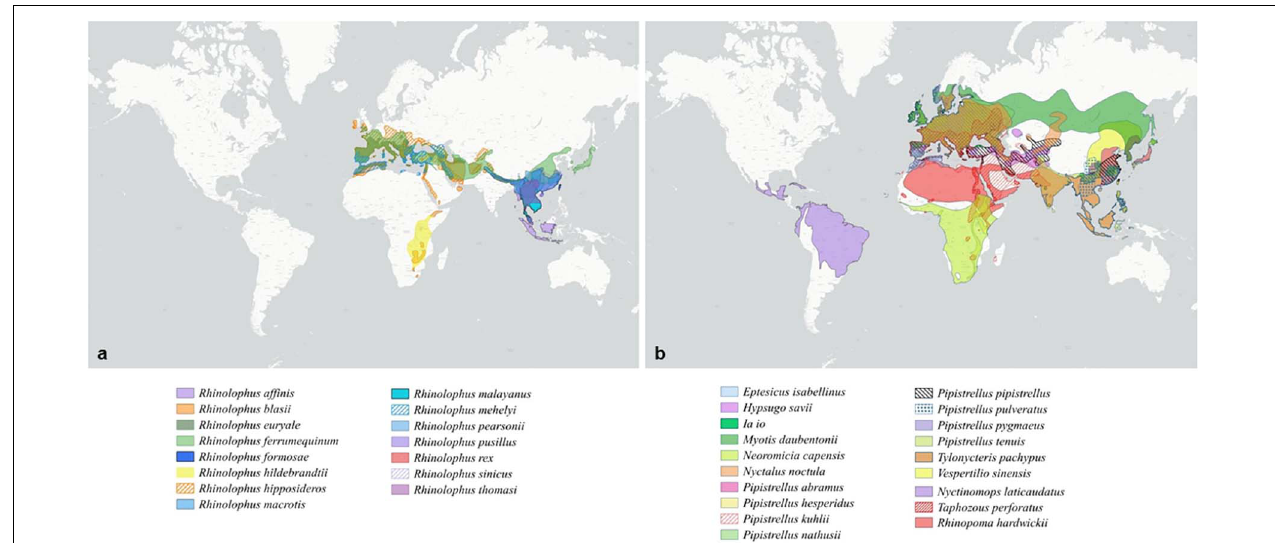
FIGURE 1 | Distribution of bat species according to the group of coronavirus. (a) Distribution of bat species displaying an ACE2 receptor and associated with Sarbecoviruses. (b) Distribution of bat species displaying a DPP4 receptor and associated with